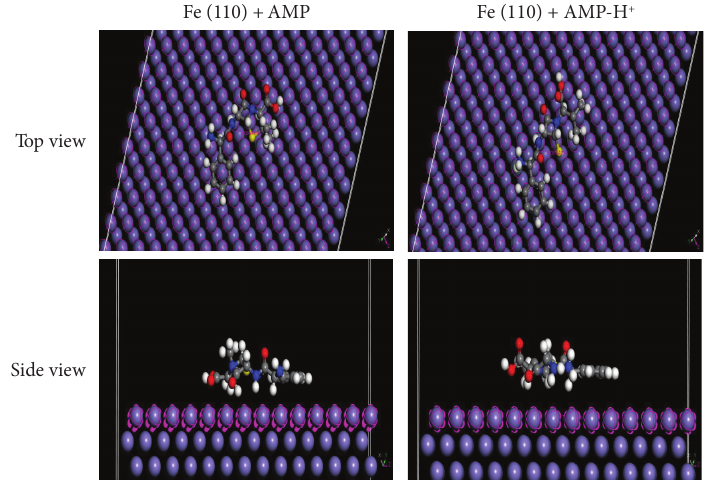
Figure 10: Top and side views of AMP and AMPH + on Fe(110) surface.